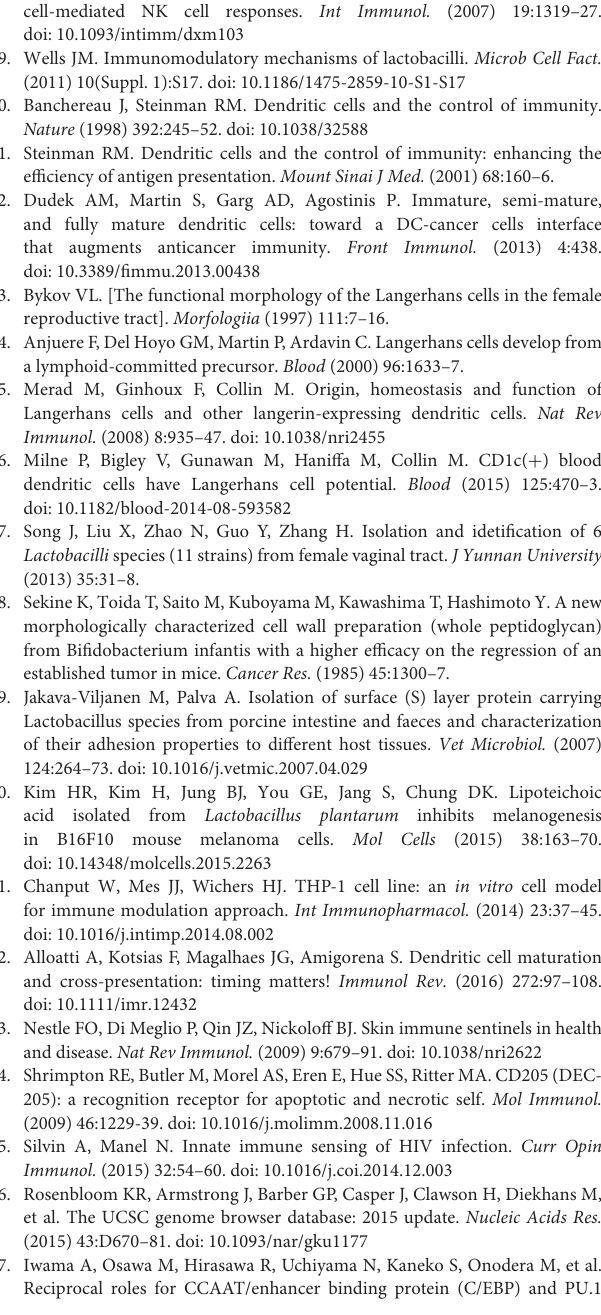
Figure S1 | CD80 expression of THP-1 after stimulation with L. crispatus THP-1 was incubated with live L. crispatus (ratio = 1:0–1:500) for the indicated times (0–96h). The percent of positive cells is presented according to MFI (mean